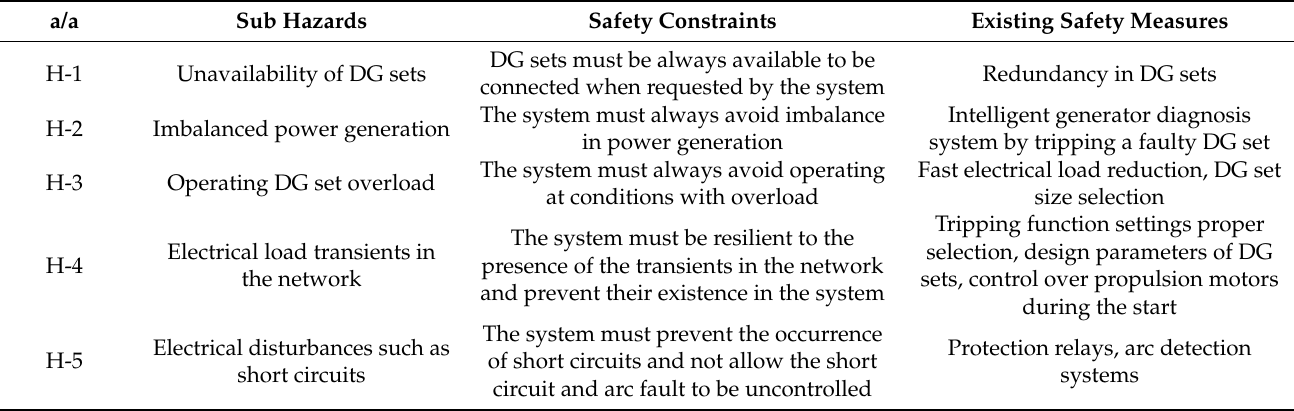
Table 5. The identified list of sub hazards, safety constraints and existing safety measures for the investigated system.